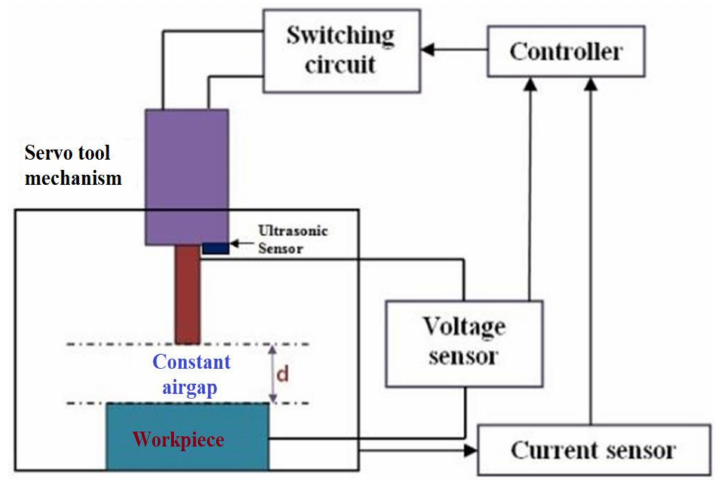
Figure 3. Design of the proposed spark control gap.